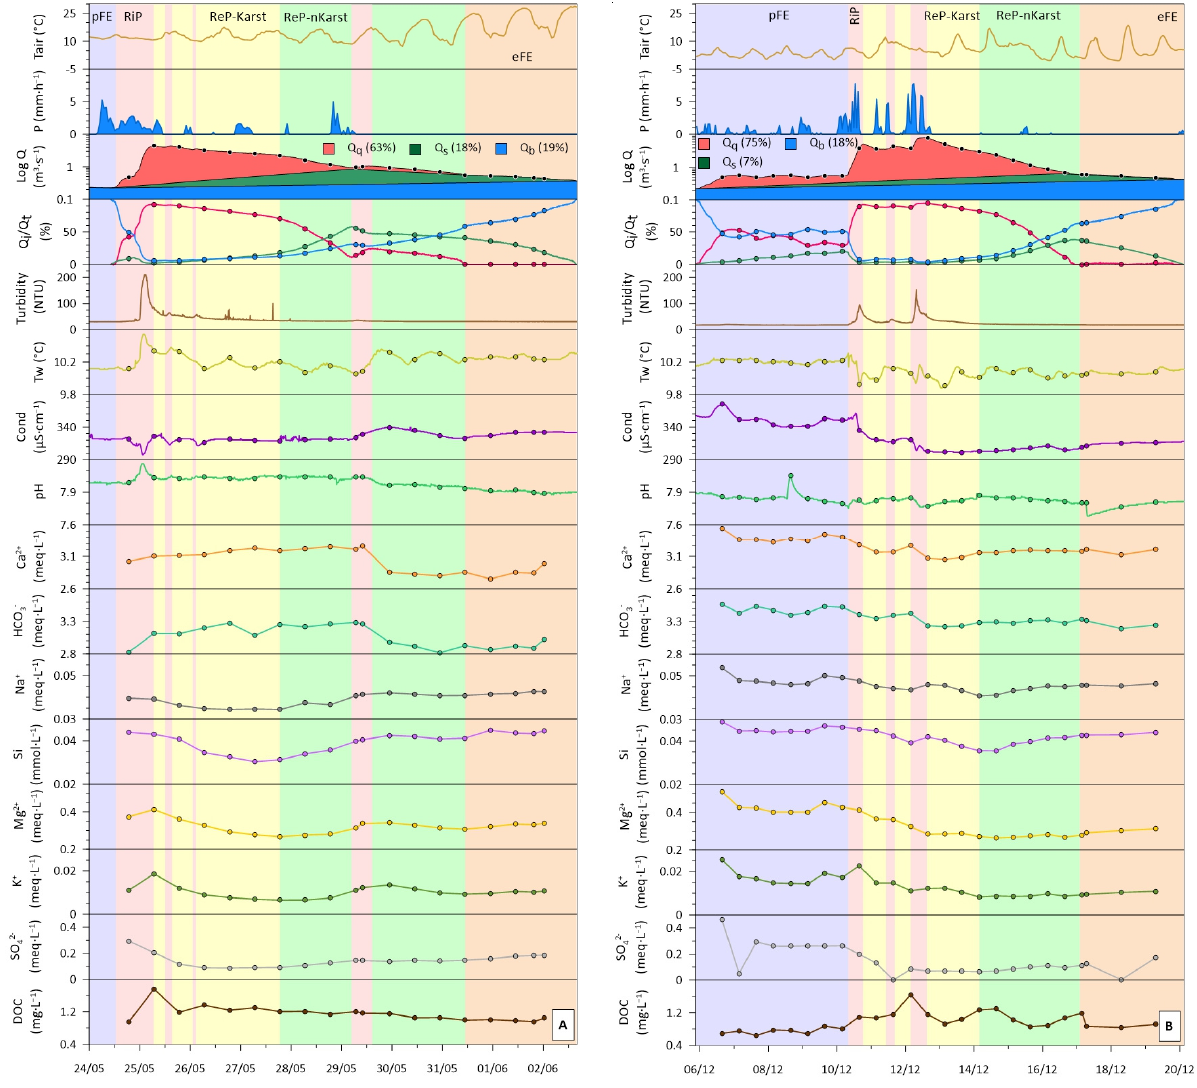
Figure 6. Hydrograph and chemographs during two flood events occurring during the study period: ( A ) for flood 2 and ( B ) for flood 11. The colors represent five stages during the flood event (violet = pre-flood event (pFE);), pink = rising period (RiP);), yellow = recession period, karst dominated flow (ReP-Karst);), green = recession period, other lithologies dominated flow (ReP-nKarst);) and orange = end of flood event (eFE). The ratio Q i /Q t represents the contribution (%) of each stream flow component to the total stream discharge: quick flow-response (Q q ) in red, subsurface flow (Q s ) in green, and baseflow (Q b ) in blue.